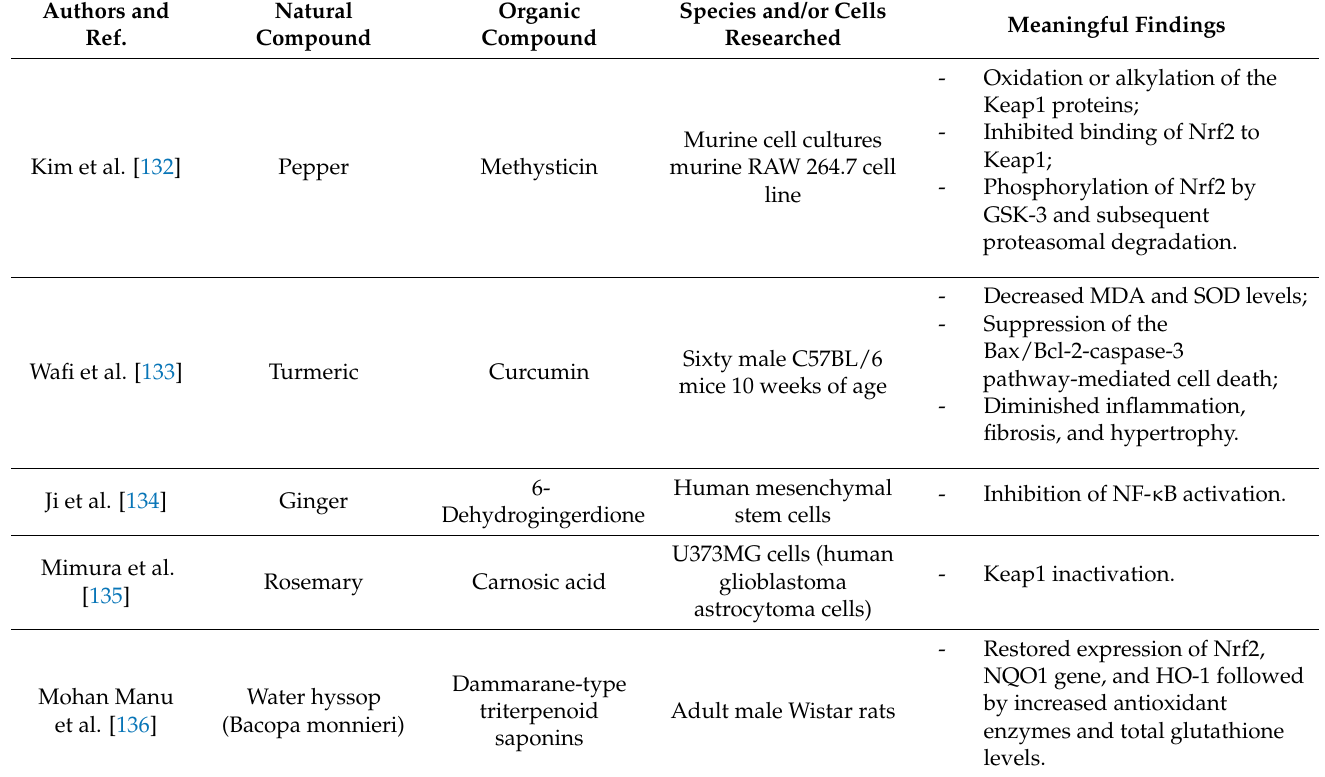
Table 1. Salient effects of natural Nrf2 activators. Kelch-like ECH-associated protein 1